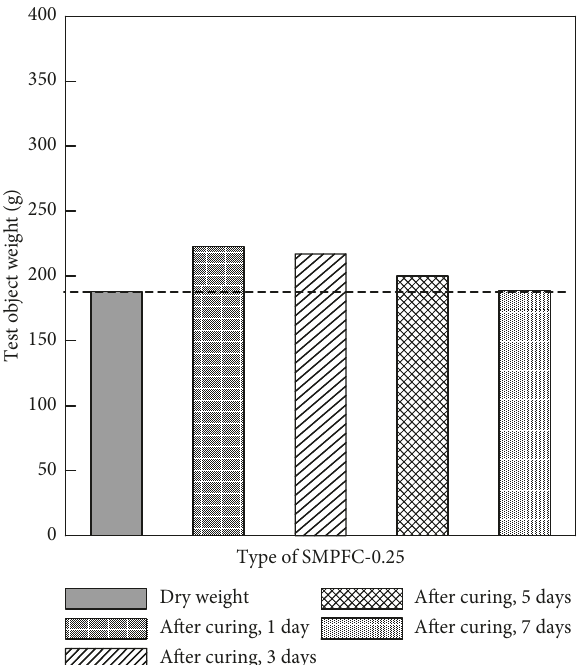
Figure 8: Surface roughness results of SMPFC.